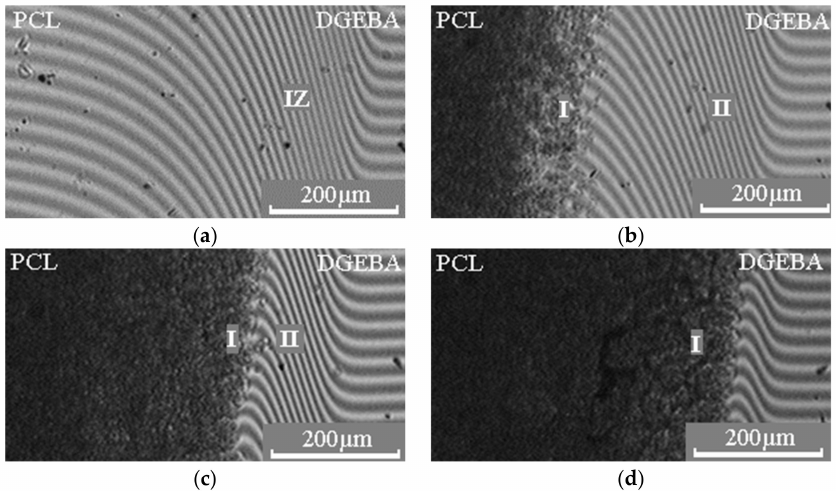
Figure 4. Interferograms of the interdiffusion zone of the PCL (M n = 45 × 10 3 ) – DGEBA system, obtained at temperatures: ( a ) 80; ( b ) 40; ( c ) 30; ( d ) 20 ◦ C. IZ is the interdiffusion zone, I is the zone of DGEBA diffusion in PCL, II is the zone of PCL diffusion in